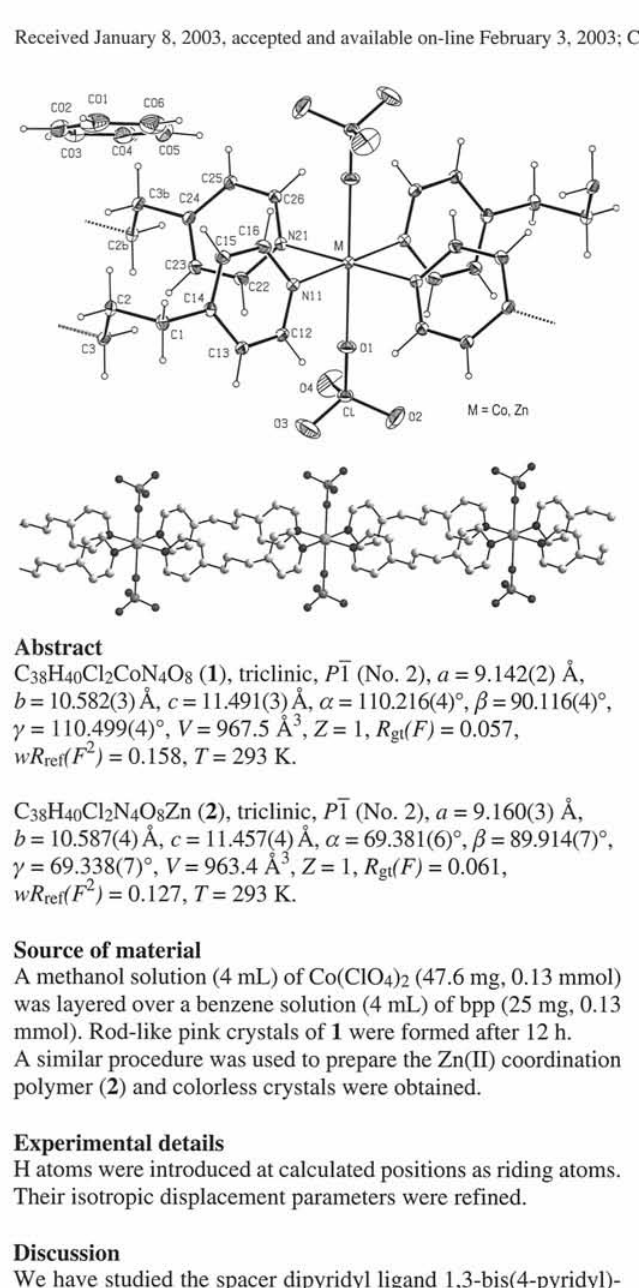
Table X. Data collection and